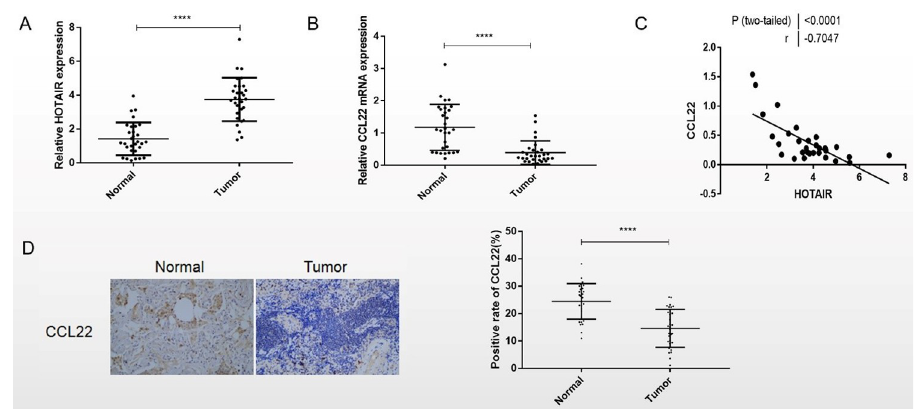
Fig 1. Clinical correlation between LncRNA HOTAIR and CCL22 in NSCLC examined. A, B: HOTAIR and CCL22 mRNA expression detected by RT-qPCR. C: The Pearson correlation analysis performed to explore the correlation between HOTAIR and CCL22 in NSCLC. D: The protein expression of CCL22 detected by immunohistochemistry in Cancer tissue and adjacent normal tissue of NSCLC. ���� , P < 0.001.